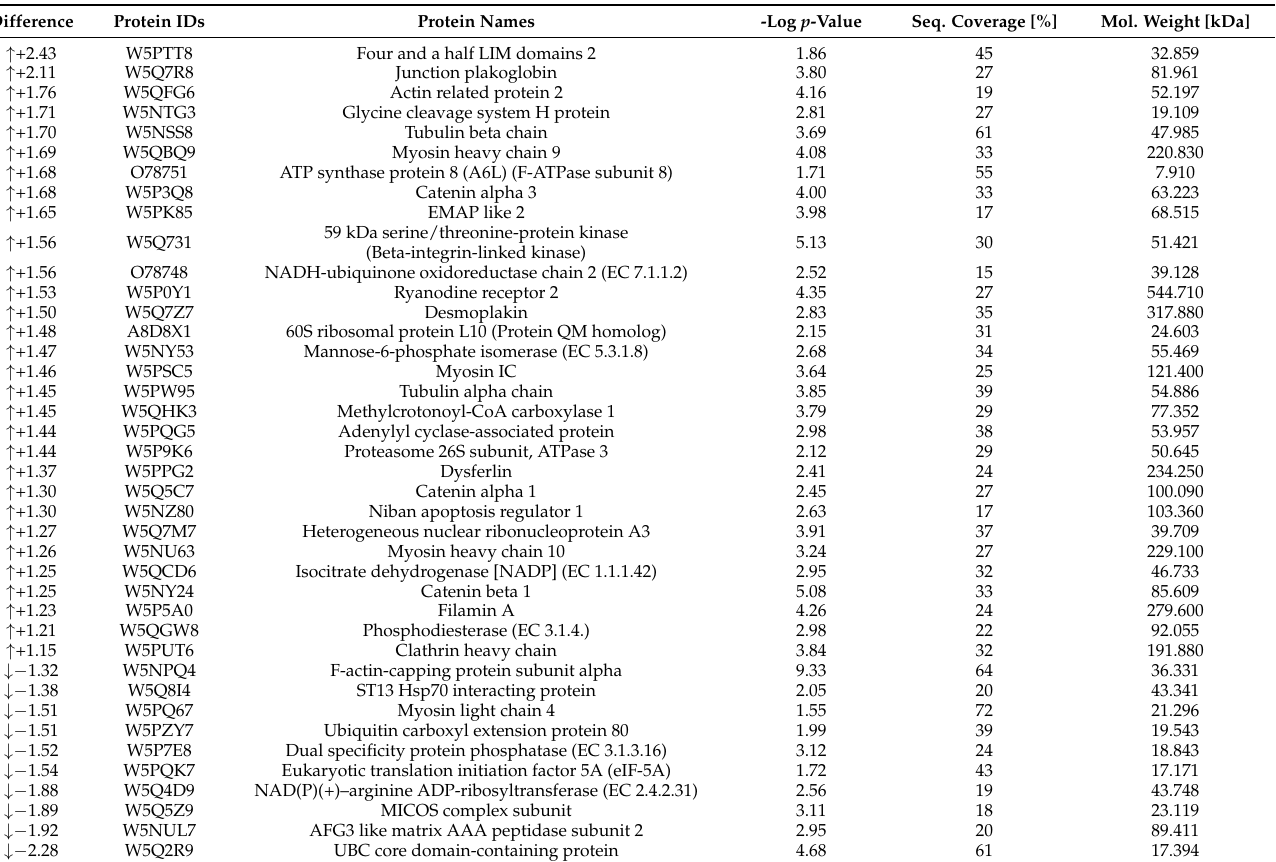
Figure 1. Overview of proteomics analysis: ( a ) the overlap between all identified proteins in Group 0 and Group SeVI, shown as a Venn diagram; ( b ) The number of up- and downregulated proteins obtained by comparing Group 0 and Group SeVI. Table 1. The list of up- ( ↑ ) and down- ( ↓ ) regulated proteins in Group 0 (2% RO, 1% FO and 0.1% CA) in comparison with Group SeVI (2% RO, 1% FO, 0.1% CA and 0.35 mg Se as Se(VI) in 1 kg BD); FDR = 1%; s0 = 1; adjusted p <